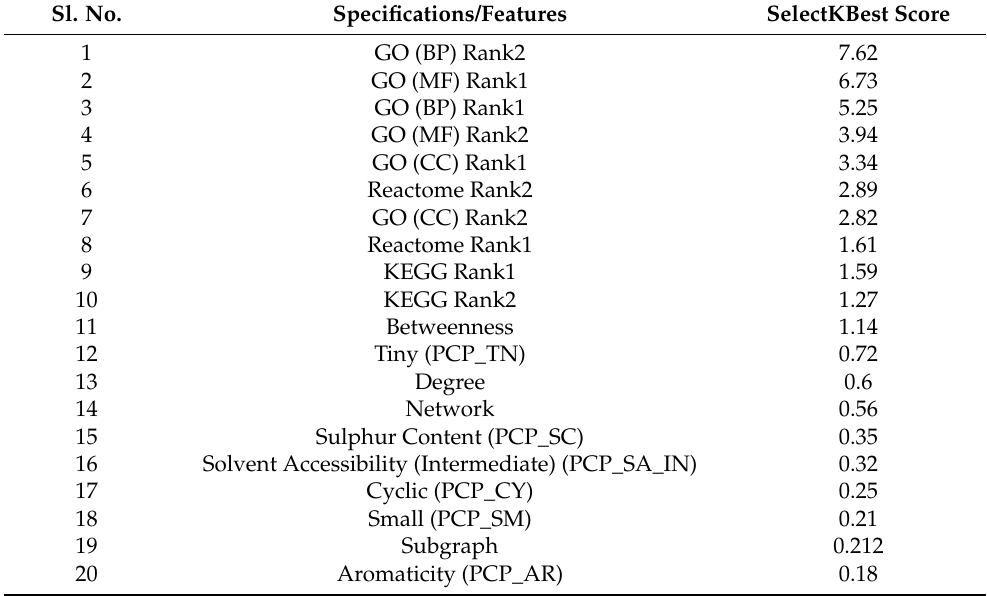
Table 1. Top twenty features selected by the SelectKBest module. SelectKBest module assigns a score to each feature which is then used for ranking. Features with lower rank are eliminated while higher ranking features are considered the most significant